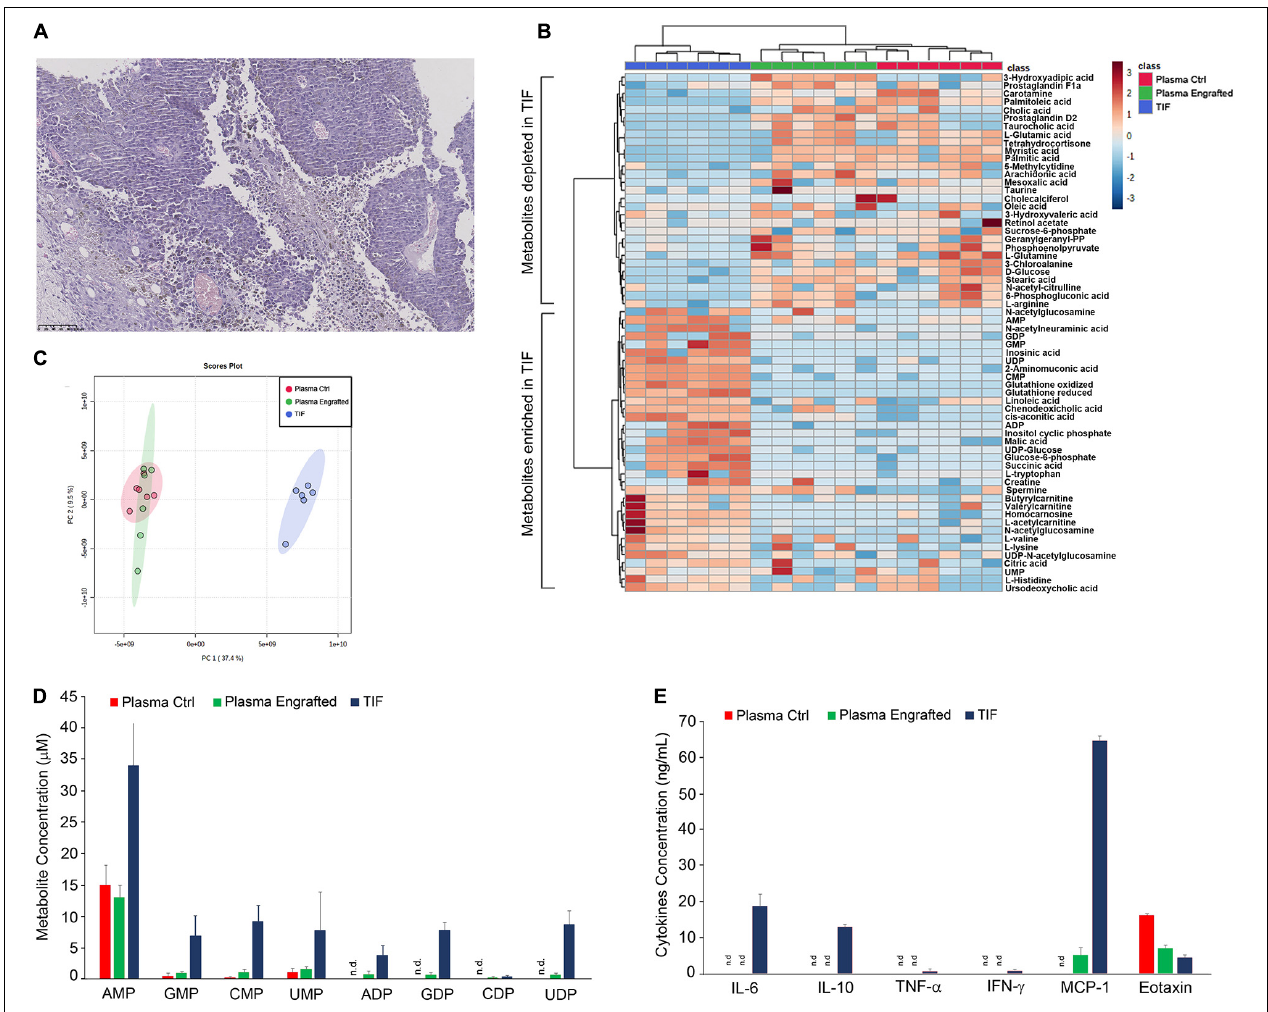
FIGURE 1 | Characterization of melanoma tumor interstitial fluid. (A) Histological analysis of tumor, deriving from C57BL6 mice engrafted with 2.0 × 10 5 B16F10 melanoma cells, stained by hematoxylin and eosin. Original magnification × 10. Hierarchical clustering (B) and principal component analysis (C) of TIF and plasma samples of tumor and non-tumor-bearing C57BL6 mice, based on LC-MS measurements. (D) Quantification by LC-MS of concentration of indicated metabolites in TIF and plasma samples of tumor and non-tumor-bearing C57BL6 mice. Values (mean ± SE, n = 6 for each group of samples) are shown. (E) Aliquots of TIF and plasma samples (30 µ l) of tumor and non-tumor-bearing C57BL6 mice were analyzed for the indicated cytokines and chemokines protein expression. Values (mean ± SE, n = 6 for each group of samples) are shown. The asterisk indicates a statistically significant difference according to Student’s t -test ( p <